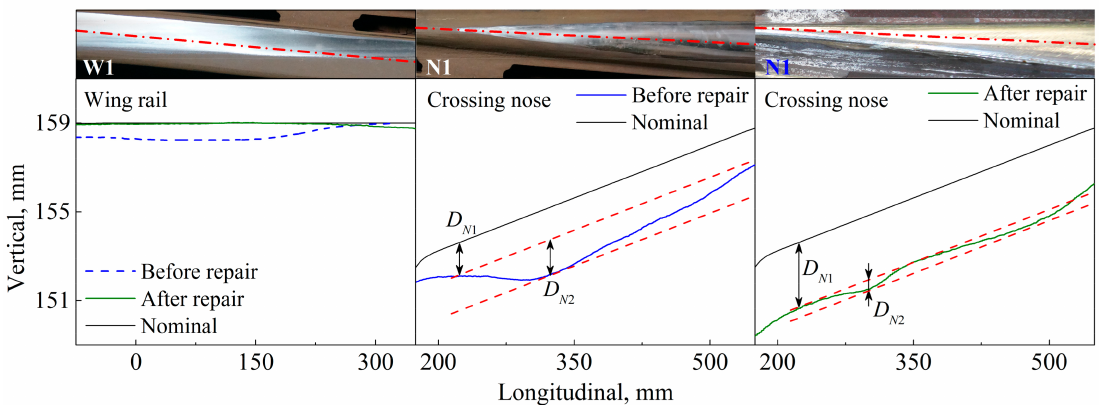
Figure 13. Change of the crossing profile due to repair. D N 1 and D N 2 indicate the height difference of the crossing